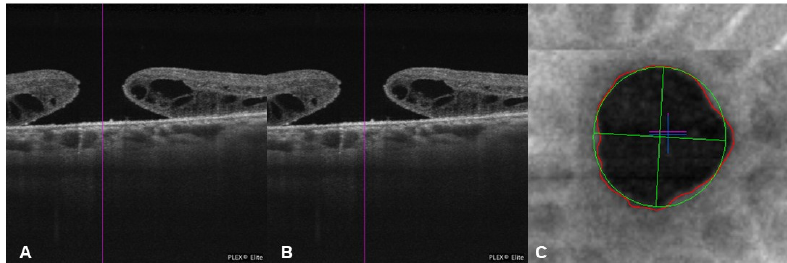
Figure 4. The longest macular hole center distance case between manual and automatic detection. ( A ) Vertical B scan image of macular hole center; purple line: manual detection. ( B ) Horizontal B scan image of MH center; purple line: manual detection. ( C ) The distance between the MH center measurements obtained automatically and manually was 41µm; green cross: automatic, blue and purple cross: manual.